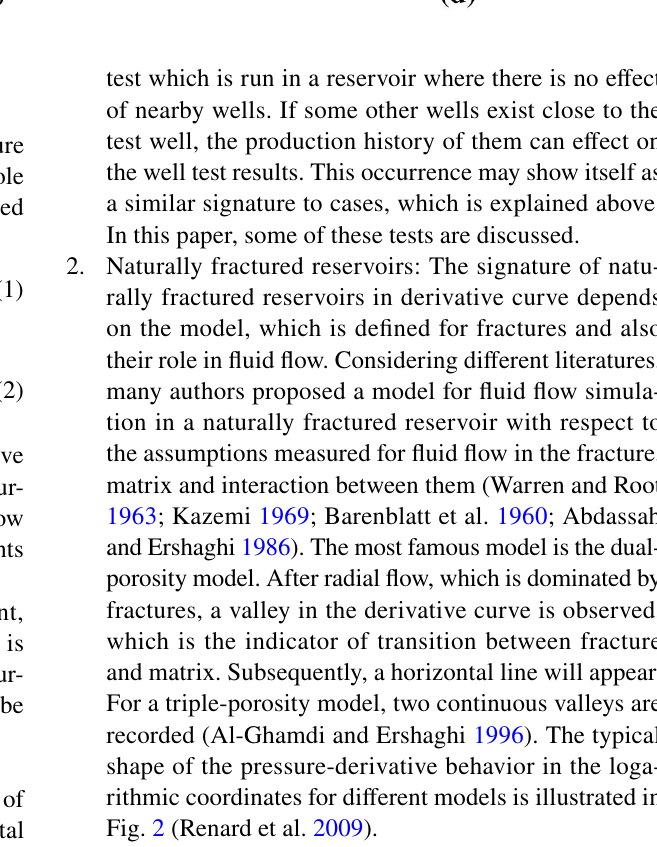
Fig. 2 Diagnostic plot of reser- voirs. a Homogenous reservoir with constant boundary pres- sure, b homogenous reservoir with no-flow boundary, c dual porosity of the naturally frac- tured reservoir, d triple porosity of the naturally fractured